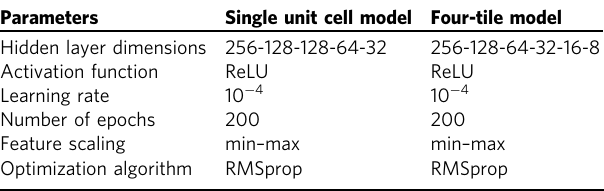
Table 2 The training parameters of the single unit cell and four-tile deep learning